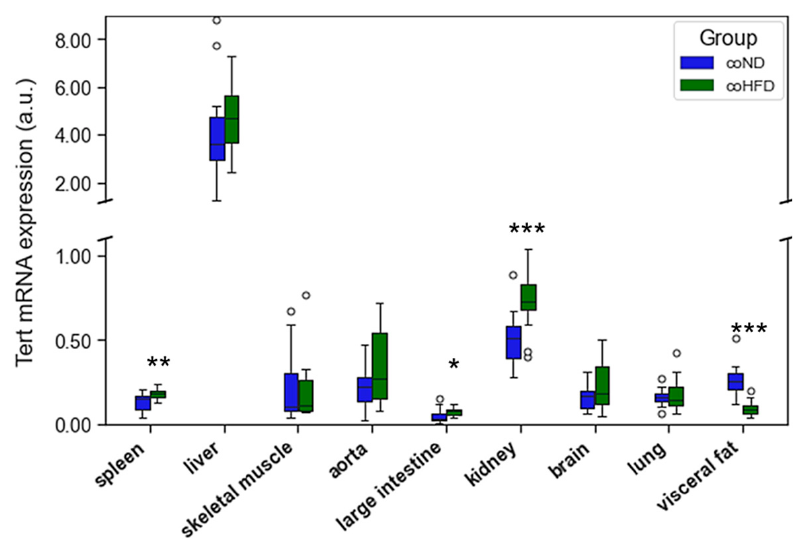
Figure 3. Differences in the TERT gene expression isolated from different solid organs of lean (coND) and obese rats (coHFD). Outliers are shown as white circles above the box plots. TERT mRNA expression is shown in arbitrary units. The two-tailed Student’s t -test or the Mann–Whitney U-test were used for group comparison of independent samples. * p < 0.05; ** p < 0.01; *** p < 0.001 vs. coND.